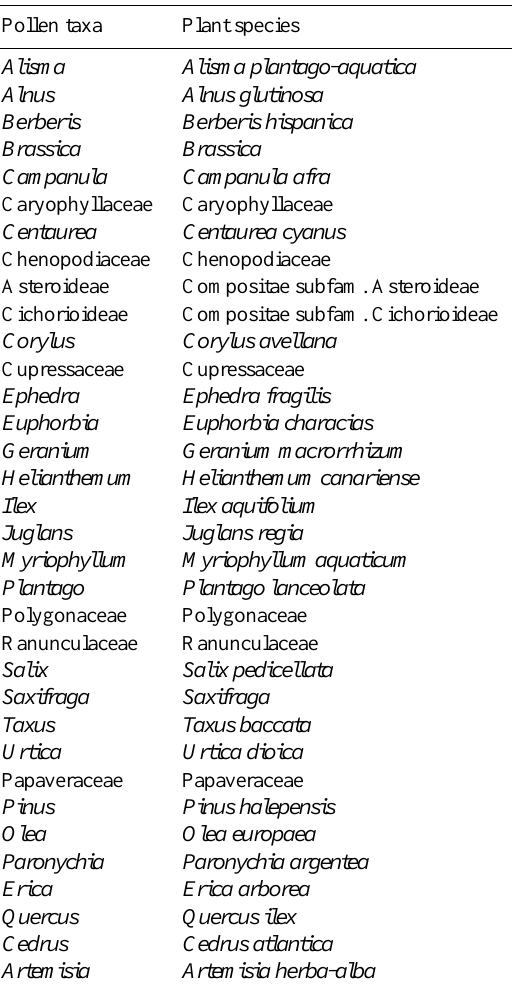
Table 2. Pollen taxa assigned to the most probable plant species in our plant